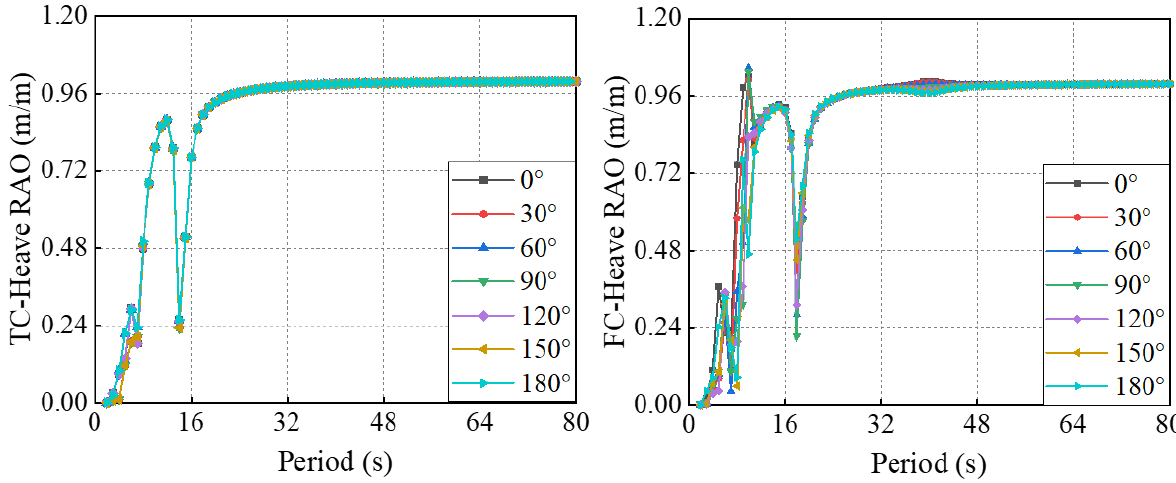
Figure 8. Heave motion RAOs of SFOWTs.